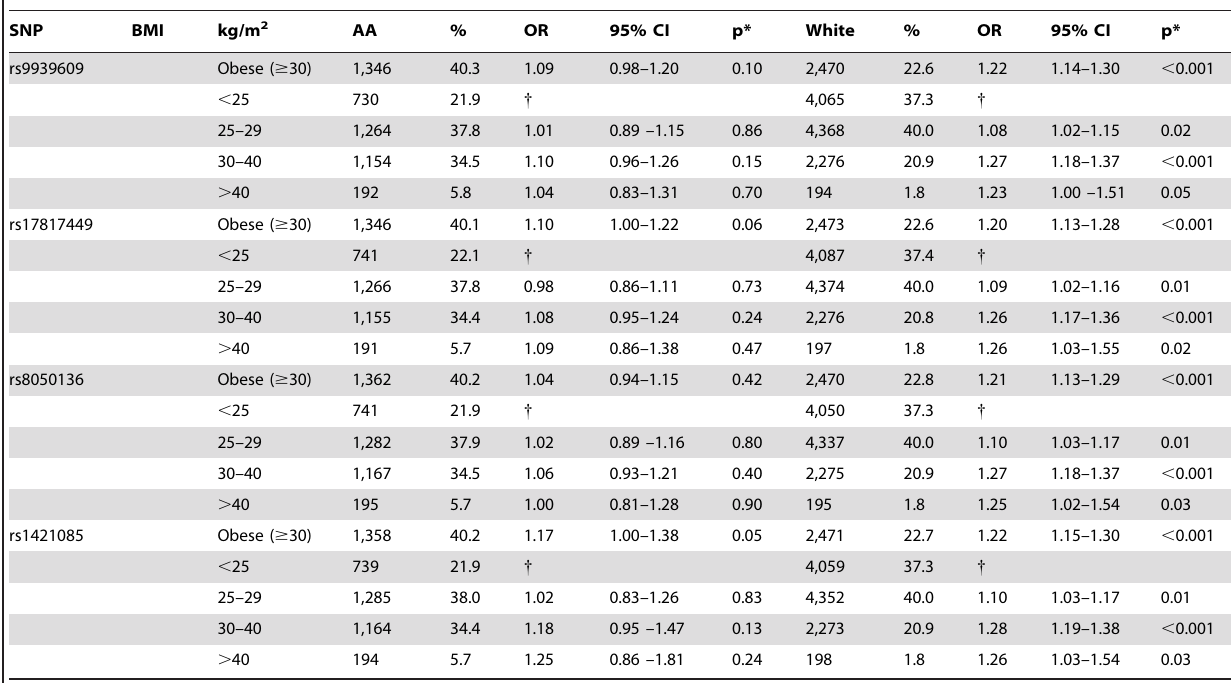
Table 4. Association of FTO and obesity or BMI stratified by race.